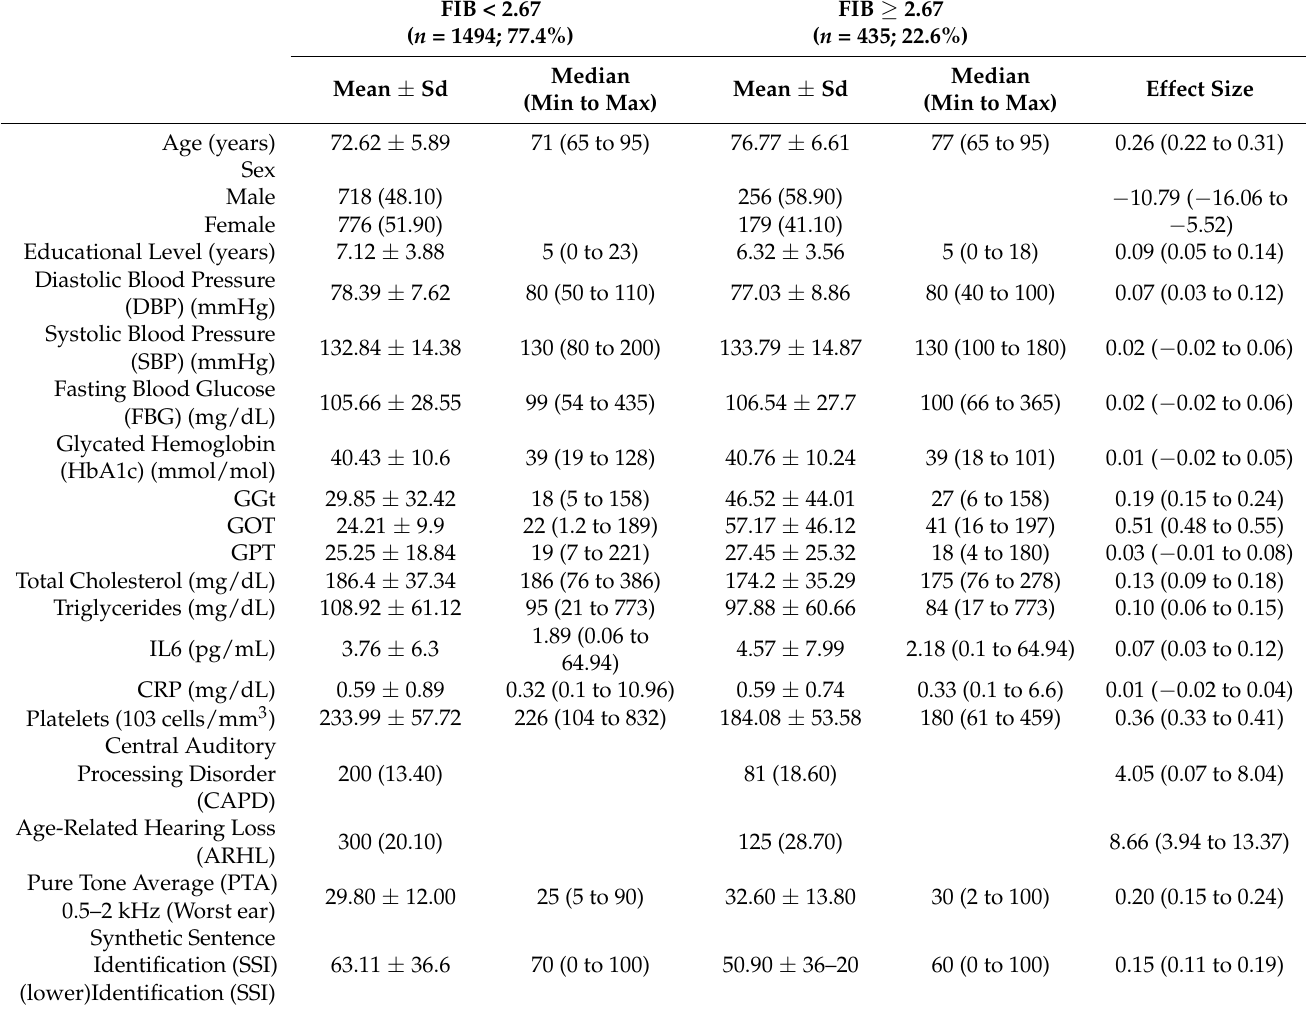
Table 1. Description of the whole sample according to FIB-4 cutoff (<2.67/ ≥